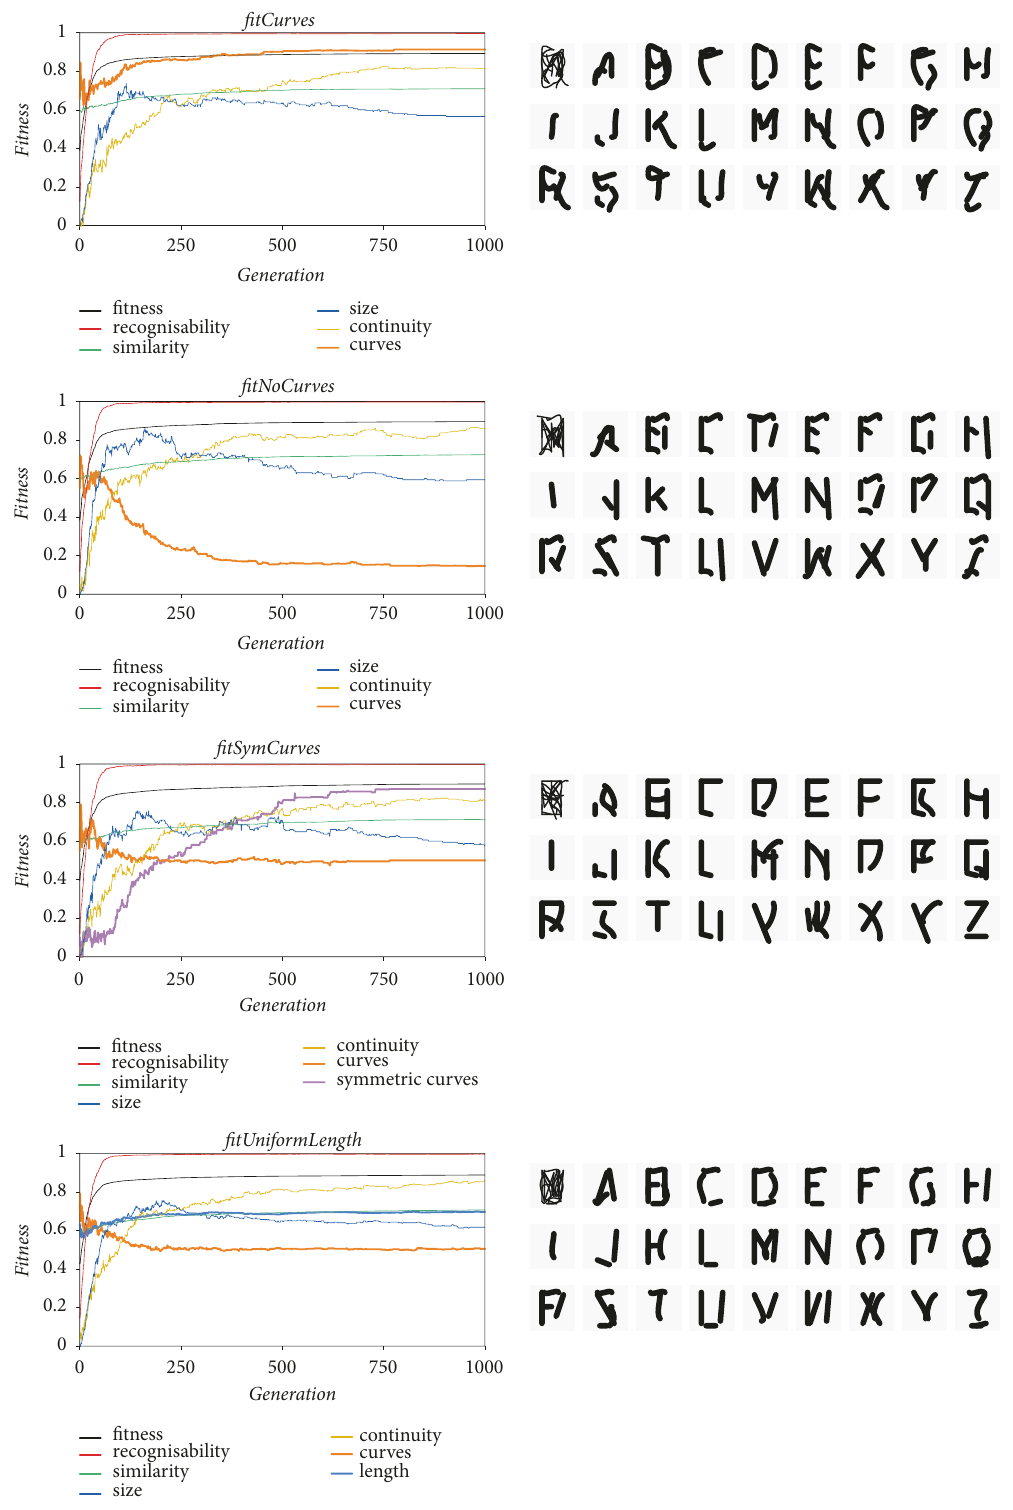
Figure 10: Experimental results when the evolutionary process is guided by fitCurves , fitNoCurves , fitSymCurves , and fitUniformLength , in descending order. For each fitness function, one can see the progression of the fitness and features’ values of the fittest stencil over the generations (left) and one typical fittest stencil of the last generation (right). The visualised results are the average of 10